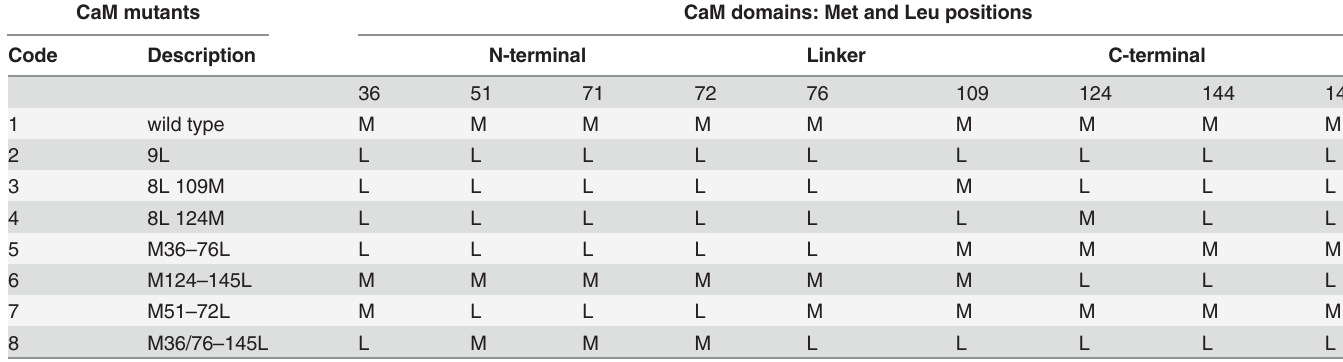
Methionine residues located in the N-teminal (Met 36, 51, 71, 72), C-terminal (Met 109, 124, 144, 145) and linker region (Met 76) of CaM are listed. Mutant description re fl ects the relative position of Met-to-Leu substitutions as schematically indicated; 9L all nine methionine mutated, 8L 109M and 8L 124M eight methionine mutated with the exception respectively of residues 109M or